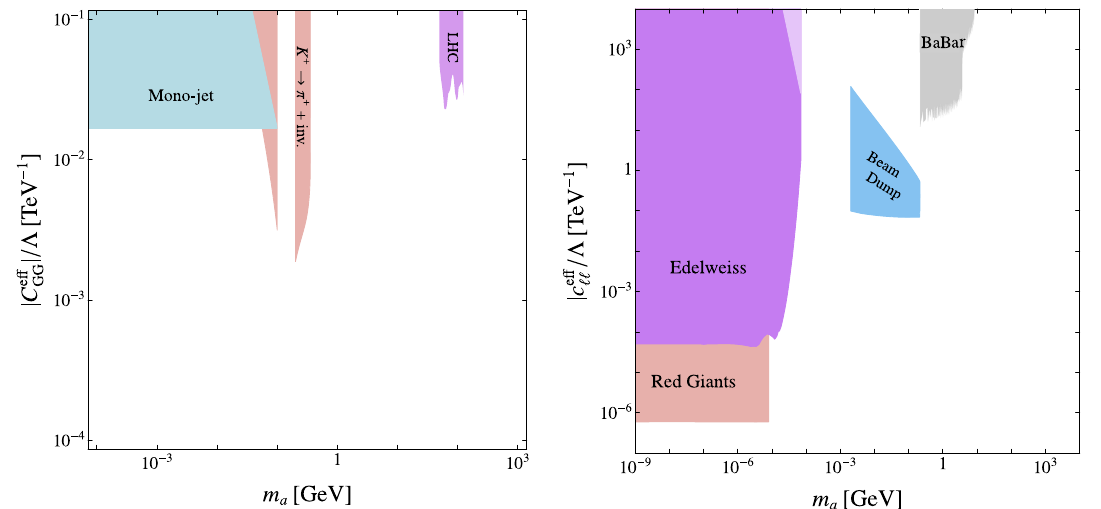
Fig. 5 Left: existing constraints on the ALP mass and coupling to glu- ons by mono-jet searches at the LHC (light blue), rare kaon decays (light red) and three-jet events (purple). Right: constraints on the ALP